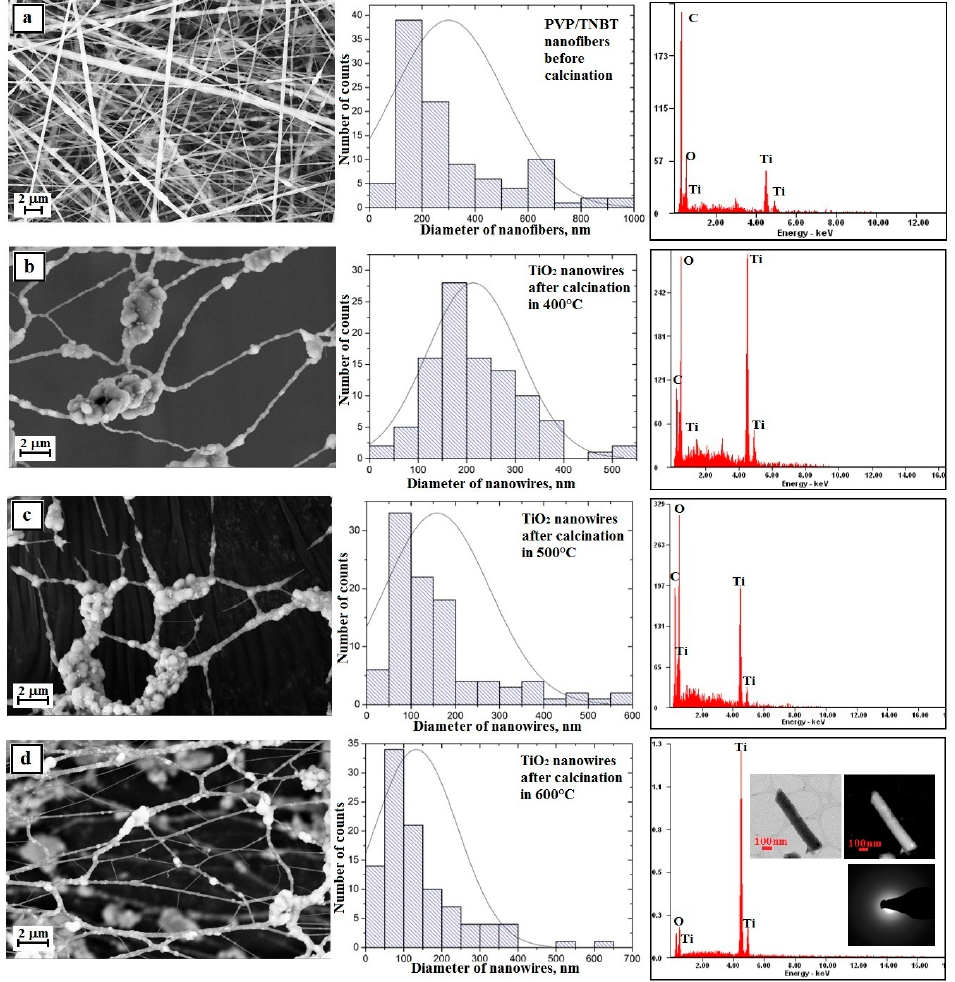
Figure 8. Left: SEM image of the topography on the surface of the formed fibrous composite mats, obtained nanowires; Middle: histograms presenting the distribution of hundredfold measurement of the diameter of randomly selected: ( a ) nanofibers obtained from PVP/TNBT/AcOH/EtOH solution, ( b – d ) TiO 2 nanowires after calcination in 400 °C, 500 °C, and 600 °C; Right: obtained EDS spectra (peaks of Al derive from the substrate on which nanofibers were deposited while Au and Pd derive from the conductive layer sputtered onto the produce nanostructures) from the entire area shown in the SEM images and TEM images for TiO 2 nanowires obtained in 600 °C an image in a light and dark area with diffraction image from single nanowires. The analysis of the SEM image of the surface topography of a fibrous mat made of PVP/TNBT hybrid composite nanofibers containing titanium dioxide nanoparticles with a 25% concentration by mass indicates that, unlike nanofibers made from a solution containing no TiO 2 nanoparticles, the obtained one-dimensional PVP/TNBT/TiO 2 structures were free of structural defects in the form of visible nanoparticle agglomerates of the used nano filler (see Figure 9a). Structural defects in the form of beads resulting from the phenomenon of hydrolysis and condensation of molecules of the used TNBT precursor were also not registered while the average diameter value of the obtained nanofibers was 300 nm, which clearly demonstrates the positive effect of the presence of nanoparticles of titanium oxide used in the spinning solution on the morphology and structure of the obtained hybrid composite nanofibers of PVP/TNBT/TiO 2 .